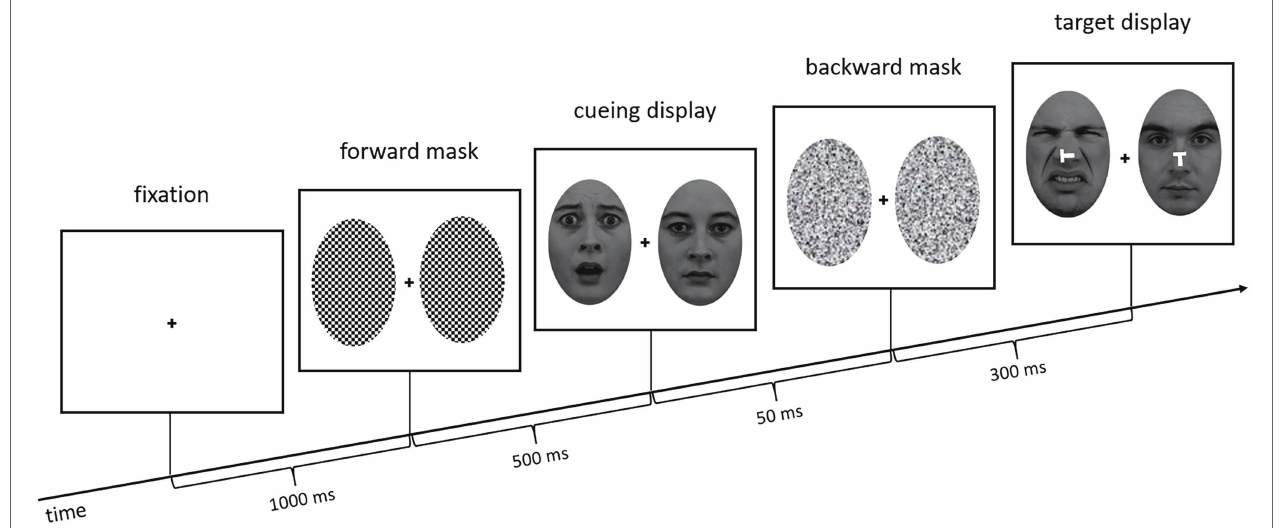
FIGURE 2 | Exemplary trial sequence of Experiment 1. The target face (neutral face) is at the right side, the distractor (disgusted face) on the left. In the cueing display, the neutral face is on the right side, and the fearful face cue is at the left (distractor position in the target display, hence, an invalid trial). Stimuli are not drawn to